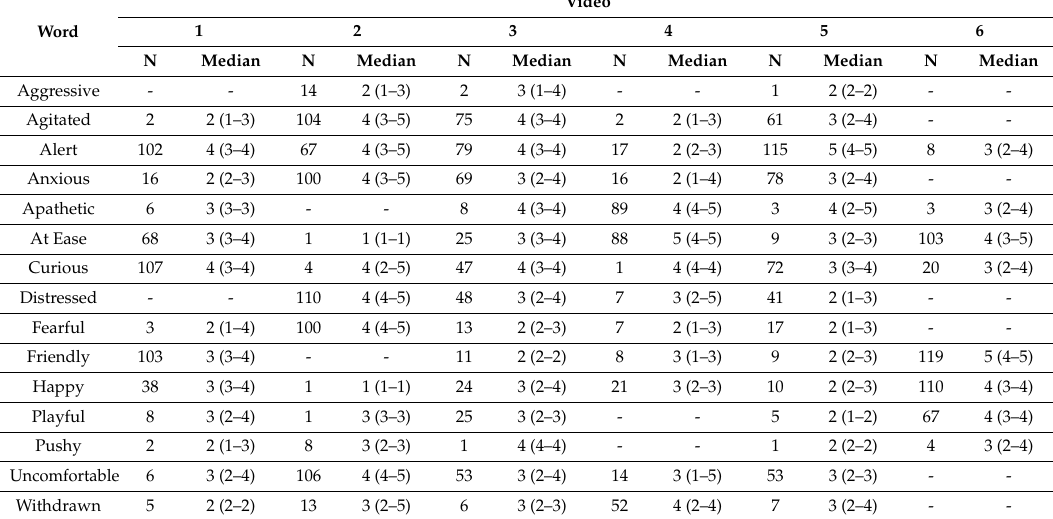
Table 4. Number of students that selected each pre-defined term and the median (interquartile range) score for each term, selected by first-year veterinary science or veterinary technology and undergraduate equine science students, for each of the 6 videos used in a study to assess students’ interpretation of expressive horse behaviours (- = term not selected by